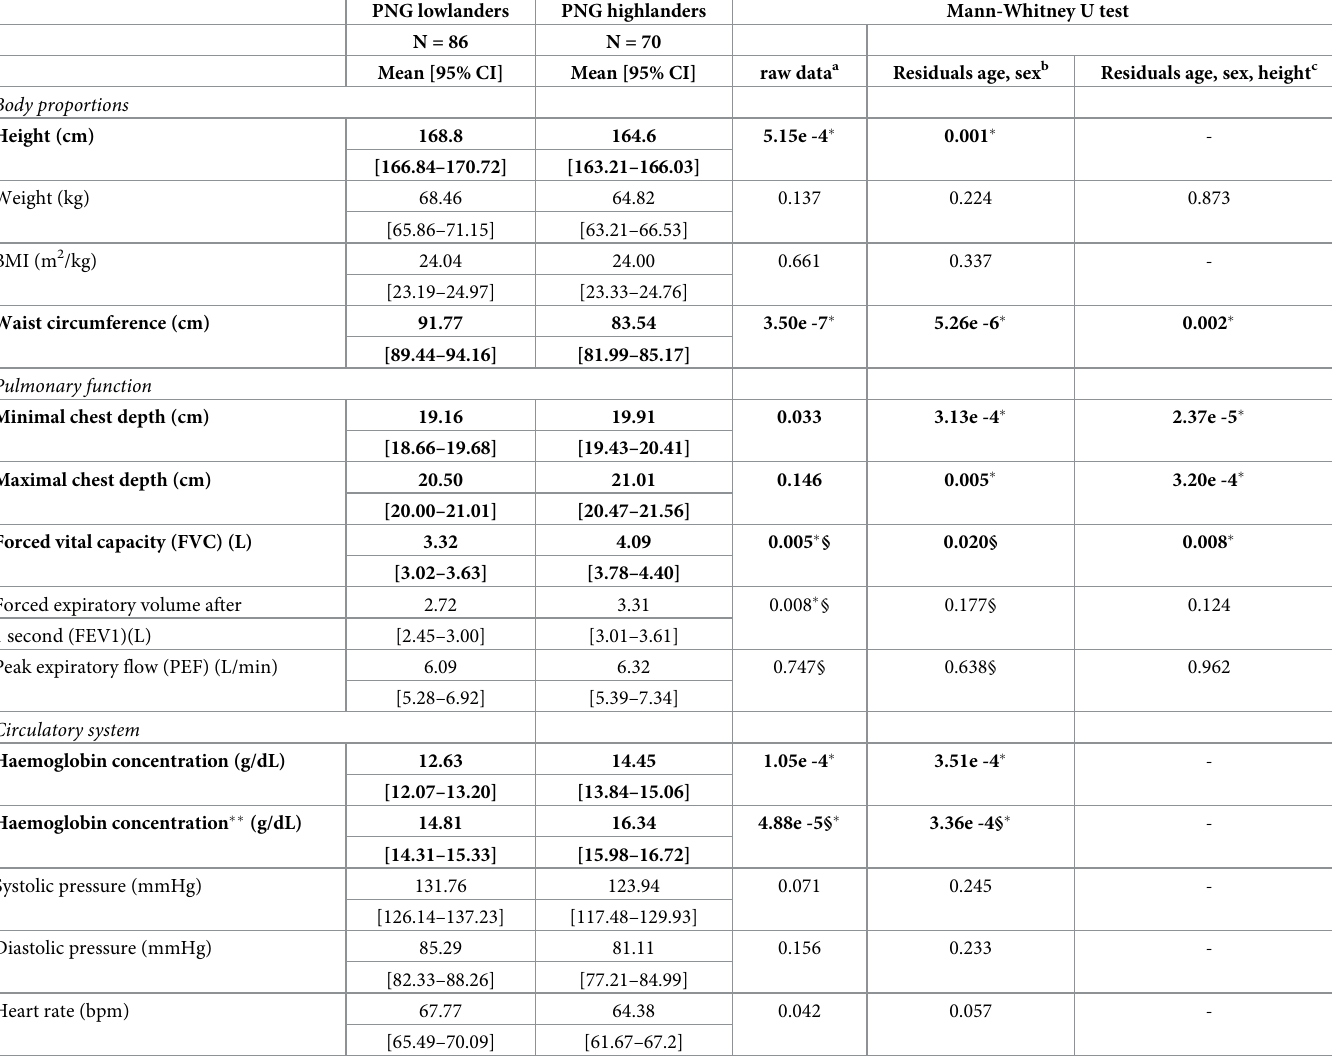
Table 1. Phenotypic comparison between PNG highlanders and